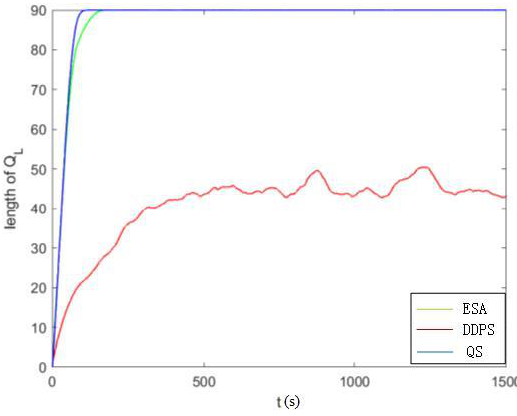
Figure 11. Comparison of low-priority queues under different algorithms.